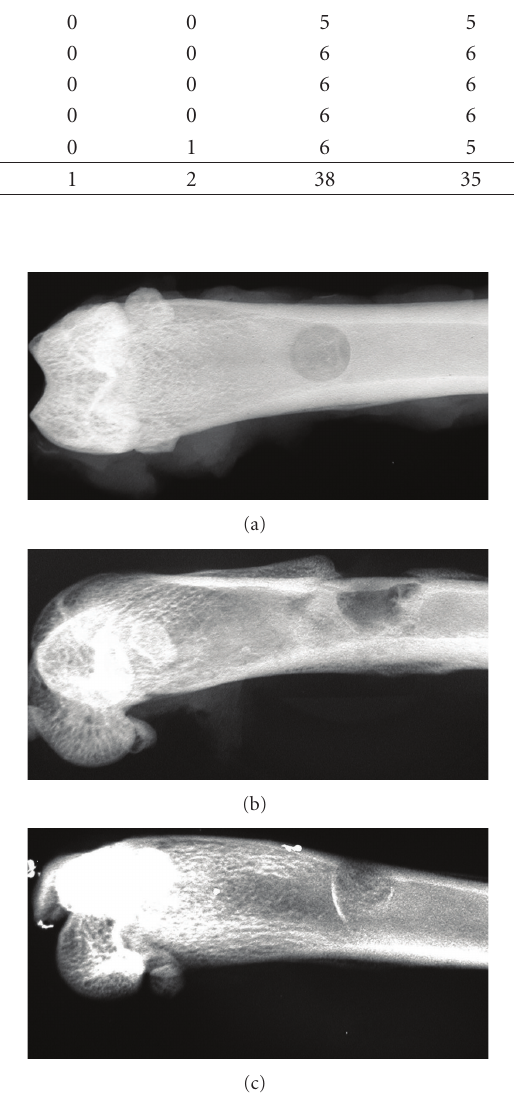
Figure 1: Post-Surgery Radiographs . Shown are radiographs of distal femur defects filled with placebo hydrogel inserts (blanks) immediate after surgery (a) or 3 weeks later (b-c). The radiographs revealed a range of healing from partially healed (b), to fully healed (c). Periosteal bone formation was evident in many samples (b).